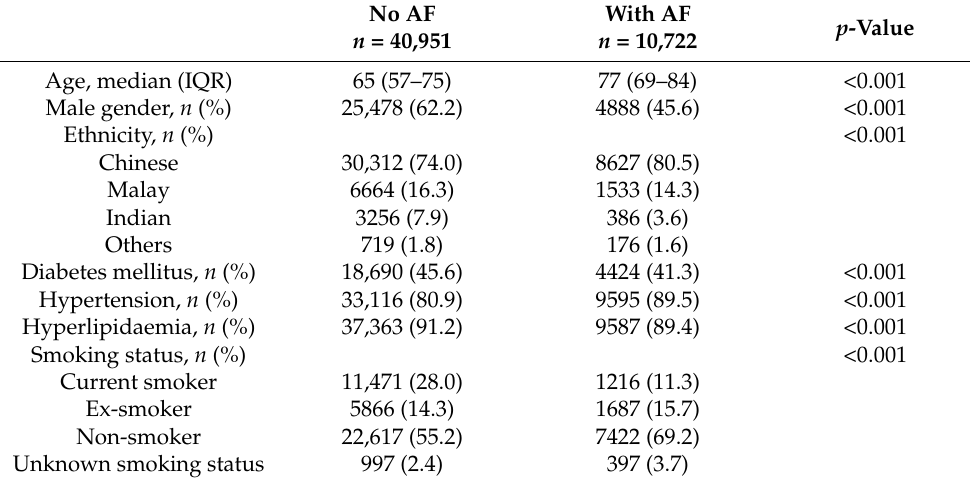
Table 1. Characteristics of patients with AIS in 2009–2018 by atrial fibrillation status ( n = 51,673